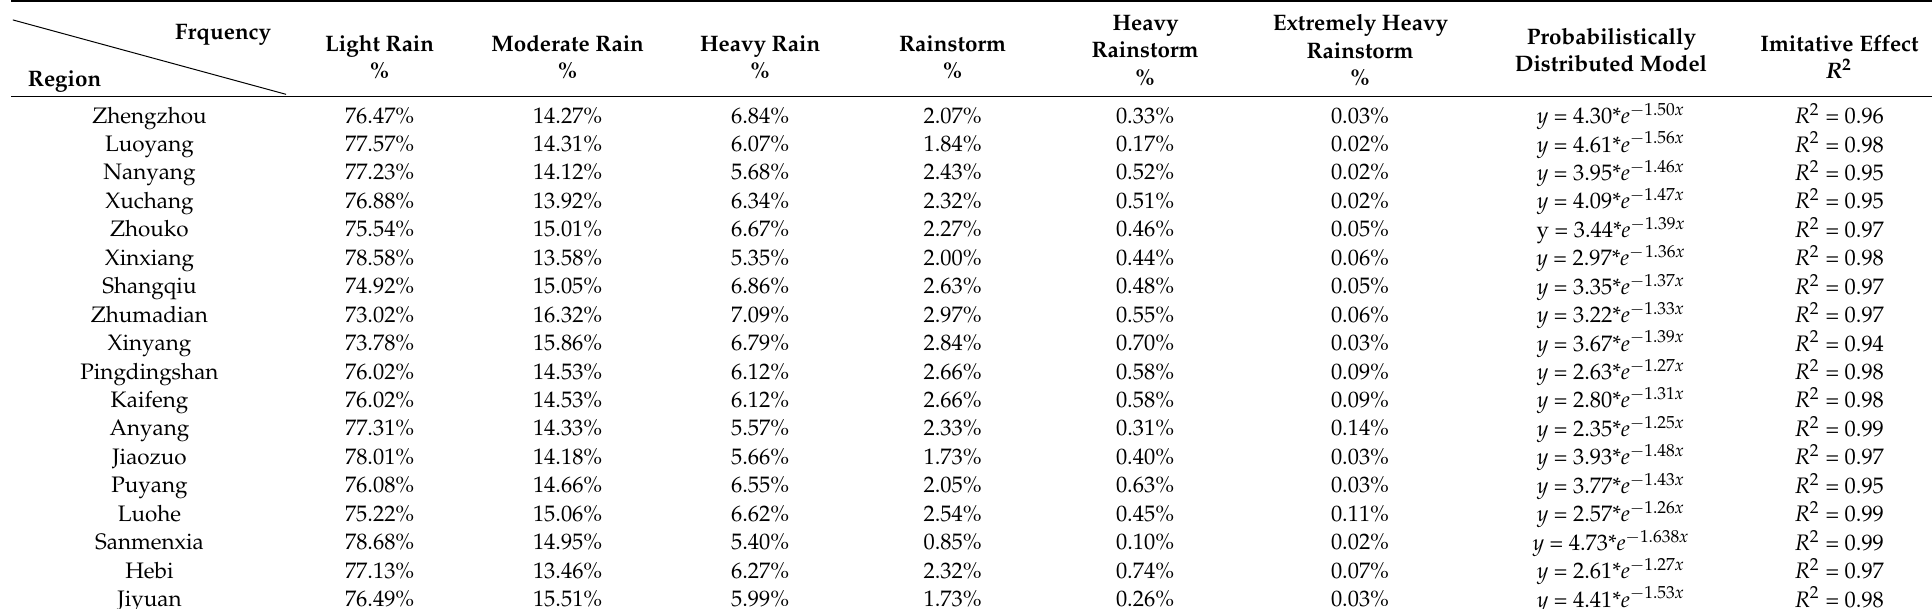
Table 2. Probability distribution table of different rainfall categories in major cities of Henan Province